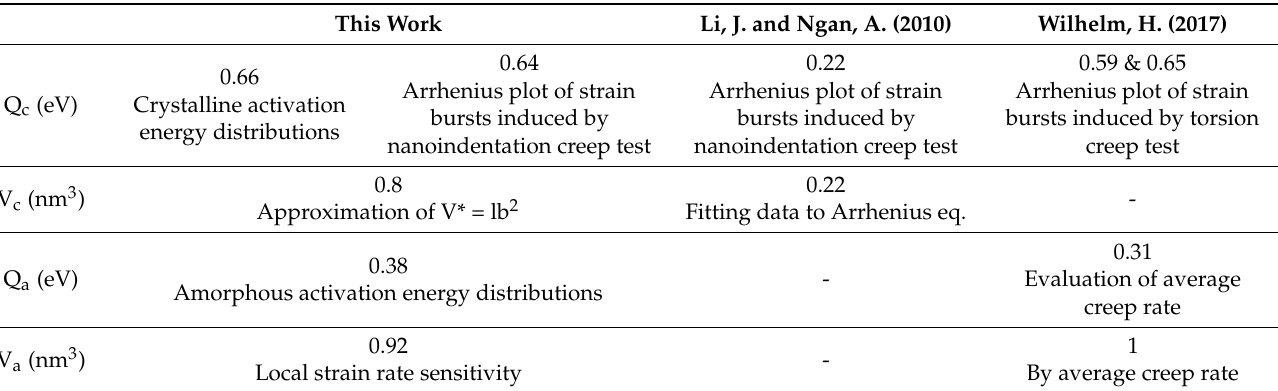
Table 1. Comparison of the activation energies and activation volumes of the crystalline and amor- phous phase of HDPE (Q c , V c , Q a , V a ) obtained in this study with the results obtained by Li et al. and